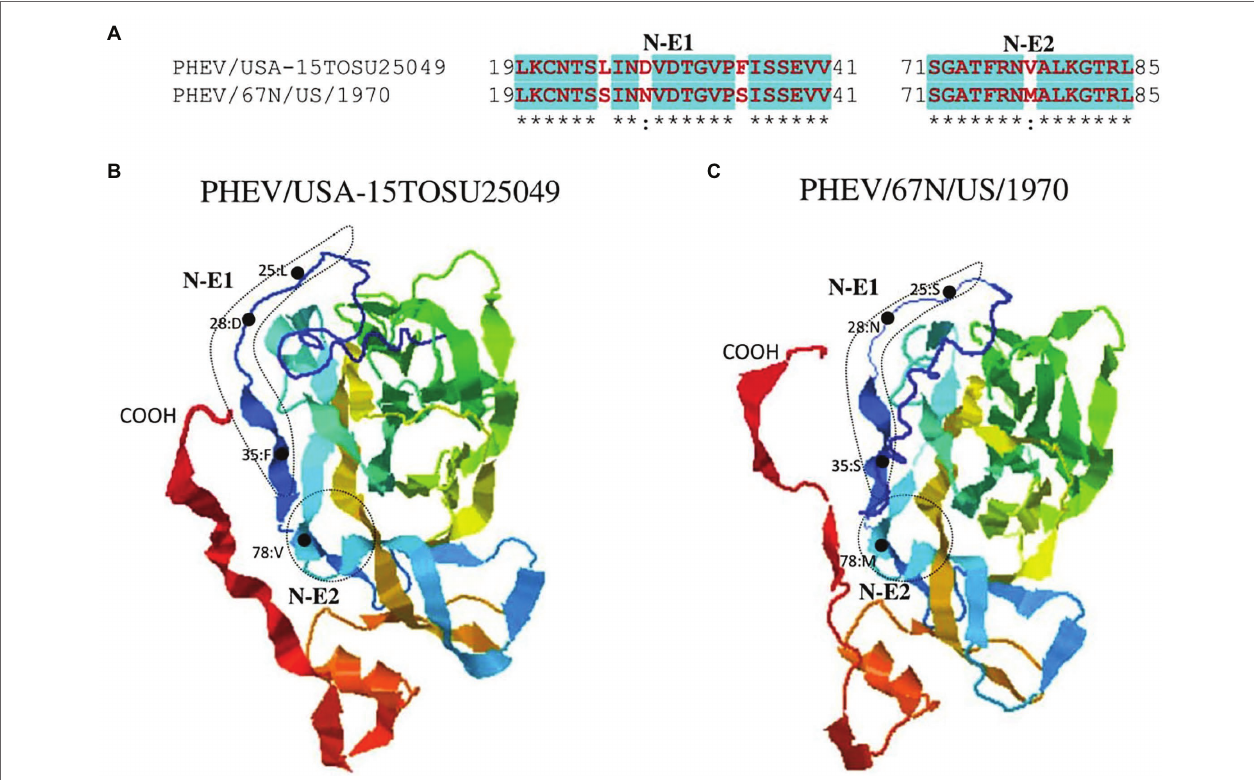
FIGURE 5 | Comparison of linear B cell epitopes affected by amino acid variations in the NTD of S glycoprotein between PHEV/USA-15TOSU25049 and PHEV/67 N/US/1970. (A) Amino acids of the predicted linear B cell epitope are indicated with bold red letters, while numbers refer to their positions relative to the corresponding full-length S glycoprotein. Three-dimensional view of epitopes of PHEV/USA-15TOSU25049 (B) and PHEV/67 N/US/1970 (C) . The tertiary structure was modeled using I-TASER. The predicted epitopes are circled, and amino acid variations are marked with black